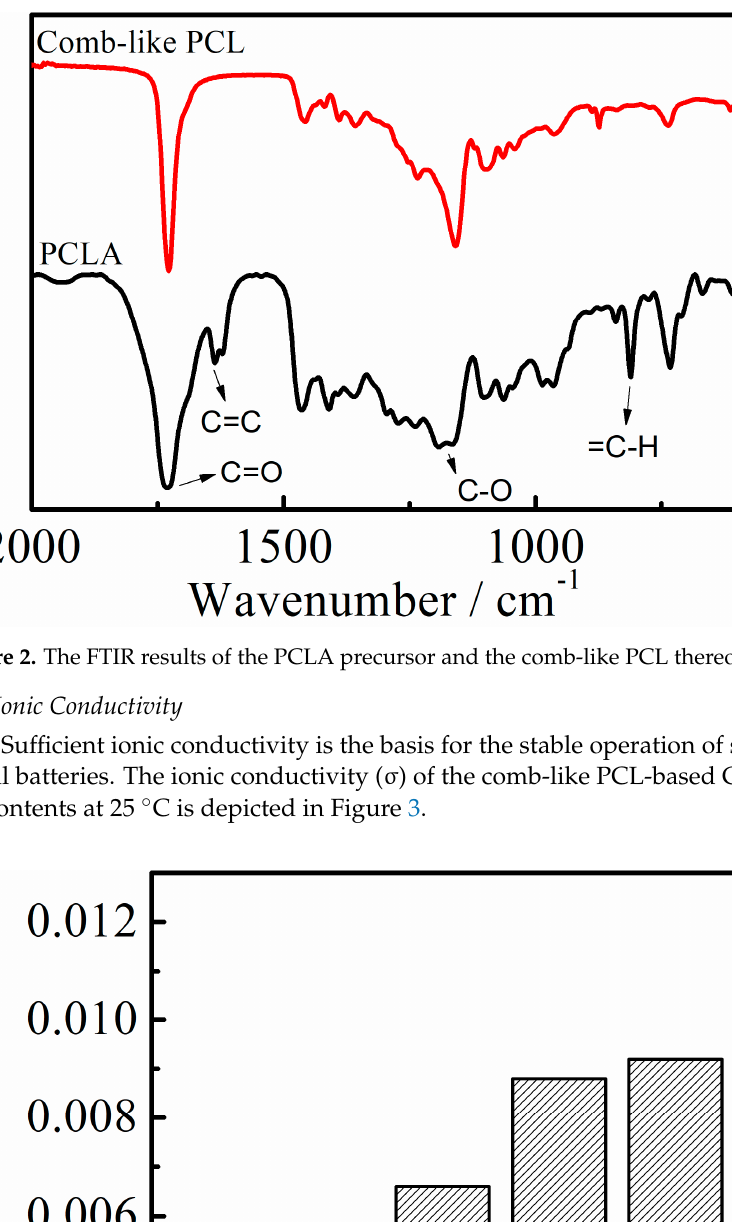
Figure 3. The ionic conductivity of the GE vs. LE contents at 25 °C.